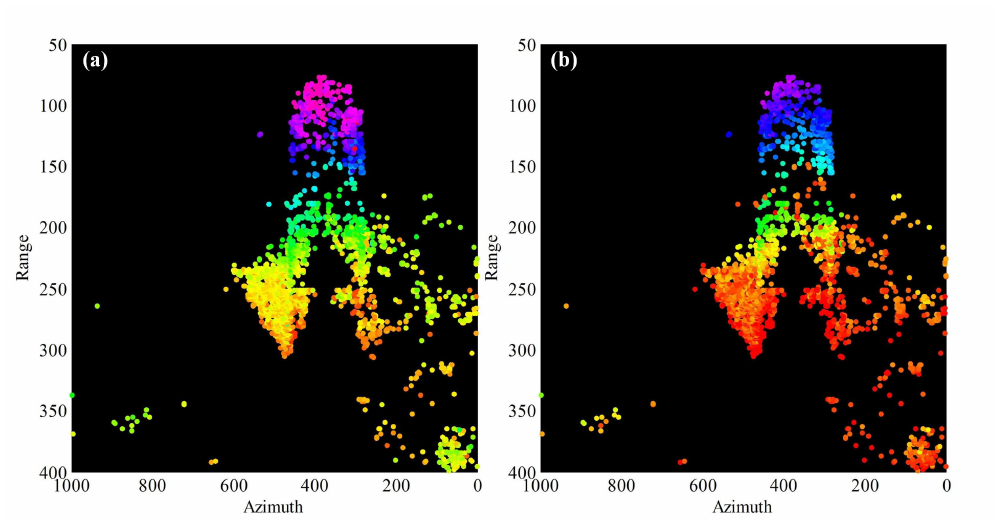
Figure 12. Study results for double scatterers: ( a ) height of the higher double scatterers; and ( b ) height of the lower double scatterers. Color bar is the same as that in Figure 11.